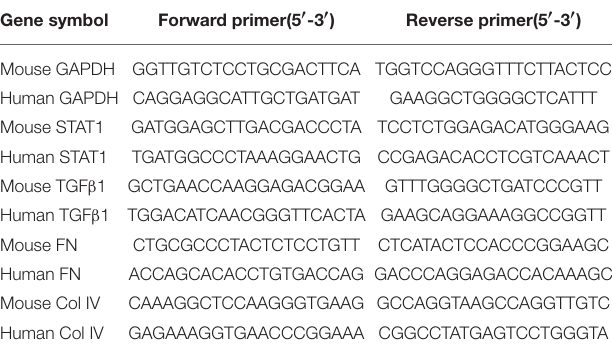
TABLE 2 | Sequences of primers used for quantitative RT-PCR analysis. Gene